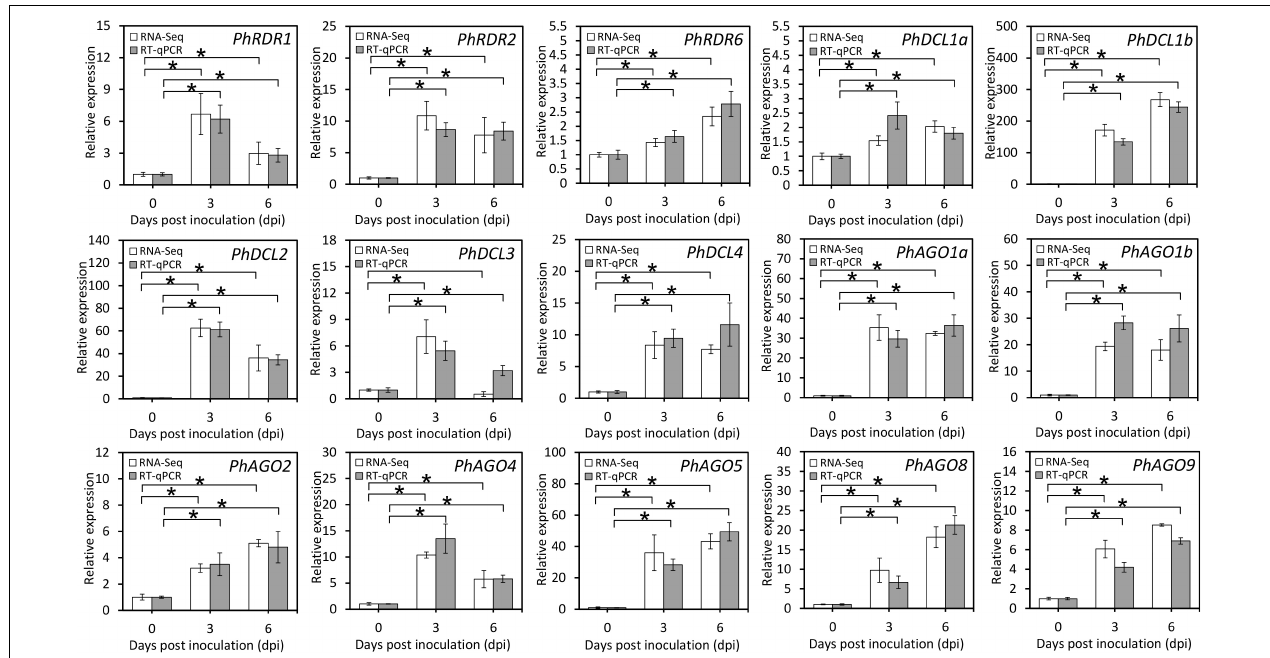
FIGURE 4 | Expression of transcripts involved in the RNA silencing pathway in TRV PPK20-infected petunia leaves. RNA-Seq and RT-qPCR analysis of transcript levels of RNA silencing-associated structural unigenes, including some RDR s, DCL s, and AGO s, in petunia leaves at different phases of TRV (PPK20) infection. 26S rRNA was used as a reference gene. Error bars represent standard error of the mean from three biological replicates. Statistical significance was determined using Student’s t -test ( P < 0.05) and shown as